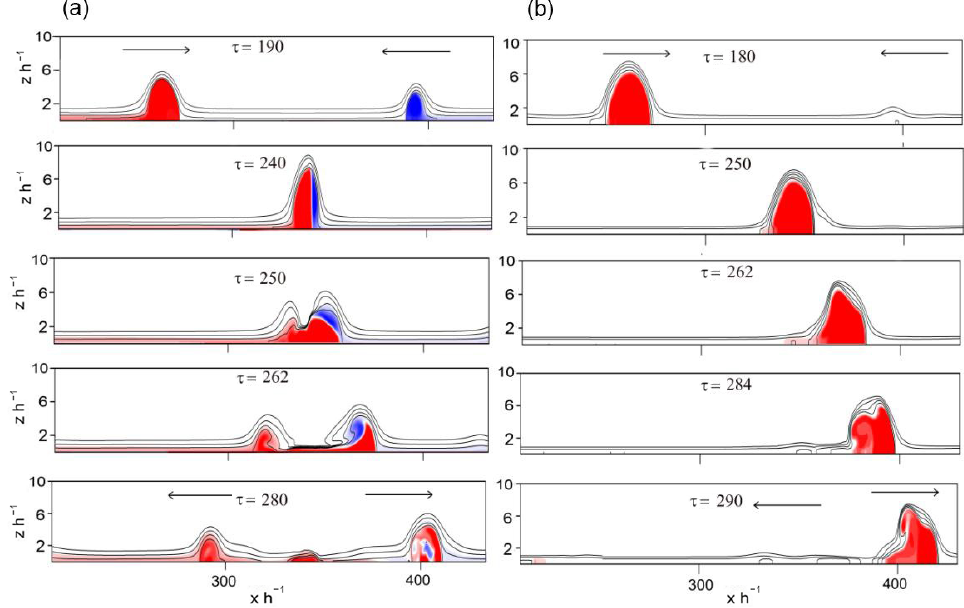
Figure 10. Snapshots of the density isopycnals during the collision of ISWs with different amplitudes for case (A9; A7) (a) and case (A11; A1) (b) . The trapped cores are visualized by dye.